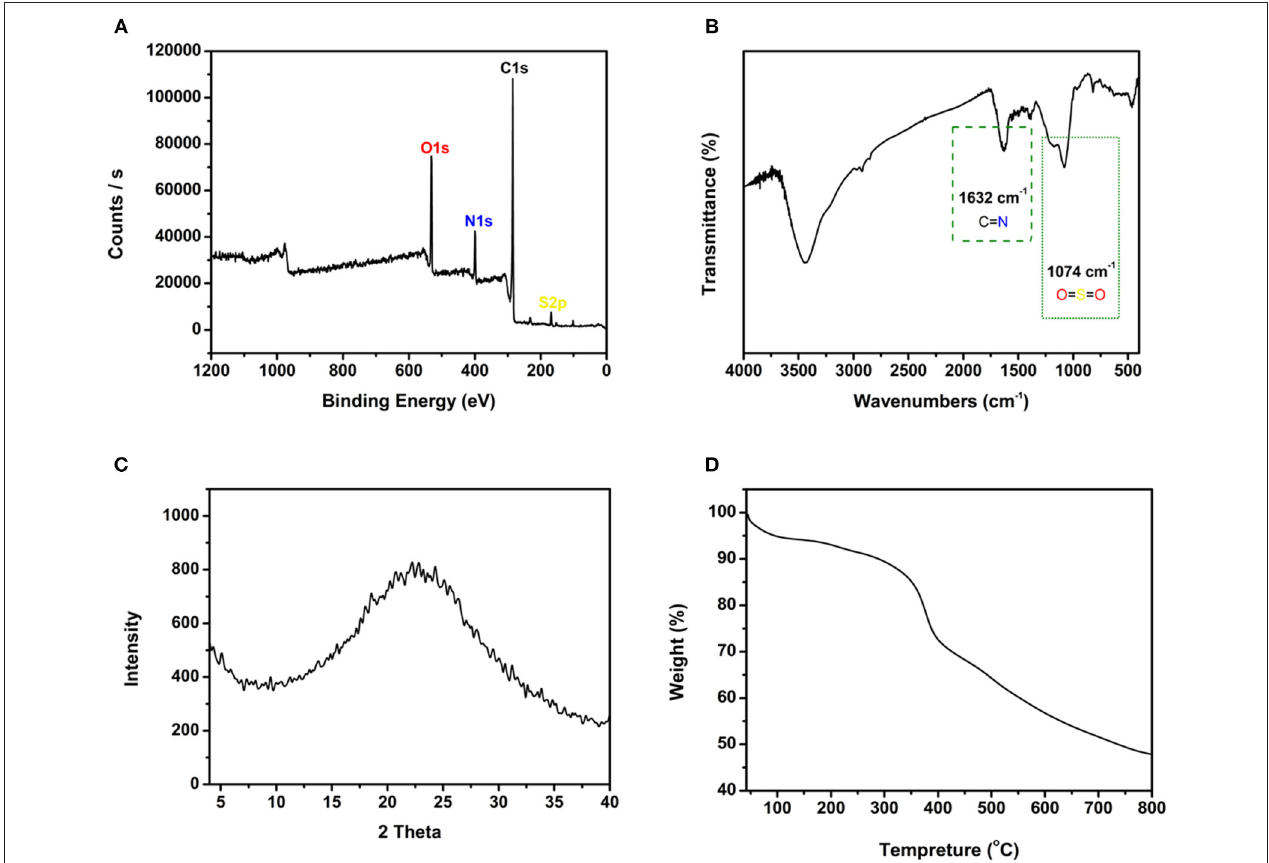
FIGURE 3 | (A) Nitrogen adsorption and desorption isotherms of JLUE-COP-3 measured at 77K and (B) pore size distribution of JLUE-COP-3.